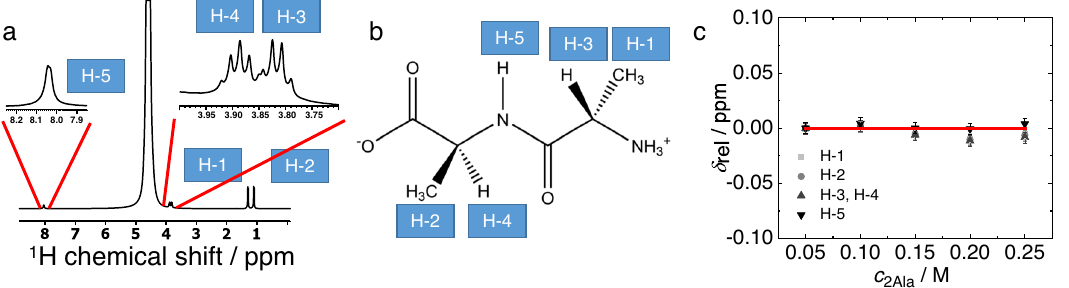
Fig. 4 1 H-NMR chemical shifts are independent of 2Ala concentration. a 1 H-NMR spectrum of 0.25M 2Ala (in H 2 O (DMSO-d5h1 capillary included). Proton signals are assigned to2Ala ’ s protons asindicated in the structureshown in ( b ). Thevariationofthe chemical shifts δ rel ¼ δ c 2Ala as function of 2Ala concentrations is shown in ( c ). The solid red-line in ( c ) corresponds to δ of ±0.005 ppm (see the